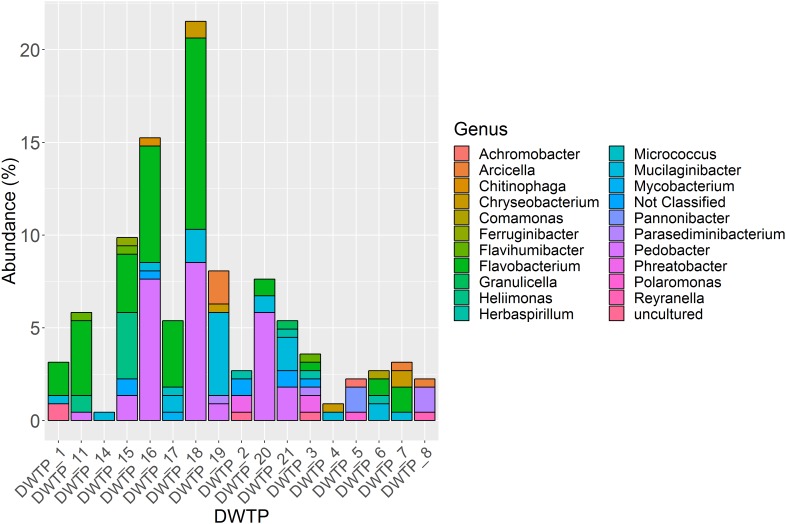
Proportion of 21 different genera among 223 identified isolates and their distribution at 17 DWTPs. Eight isolates were not identified at genus level and are thus noted as not classified. The three main genera represented are Flavobacterium (bright green), Pedobacter (bright purple) and Mucilaginibacter (turquoise).